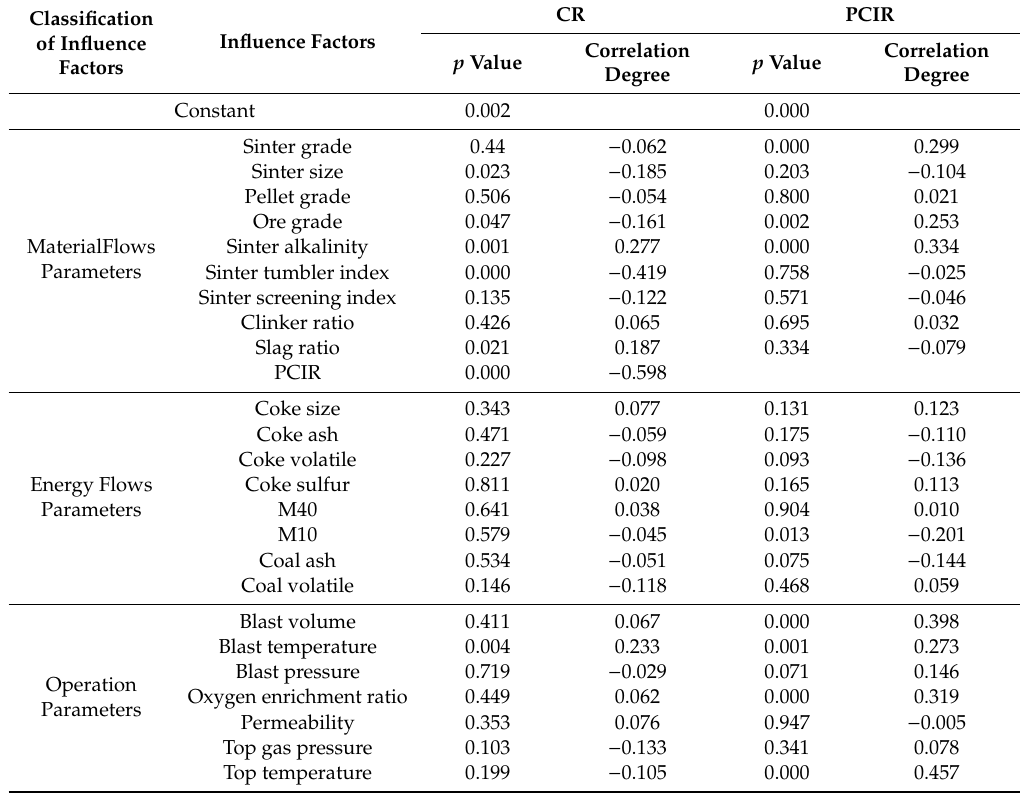
Table 1. Influence factors analysis on coke ratio (CR) and pulverized coal injection ratio (PCIR) in BFIMP by partial correlation analysis